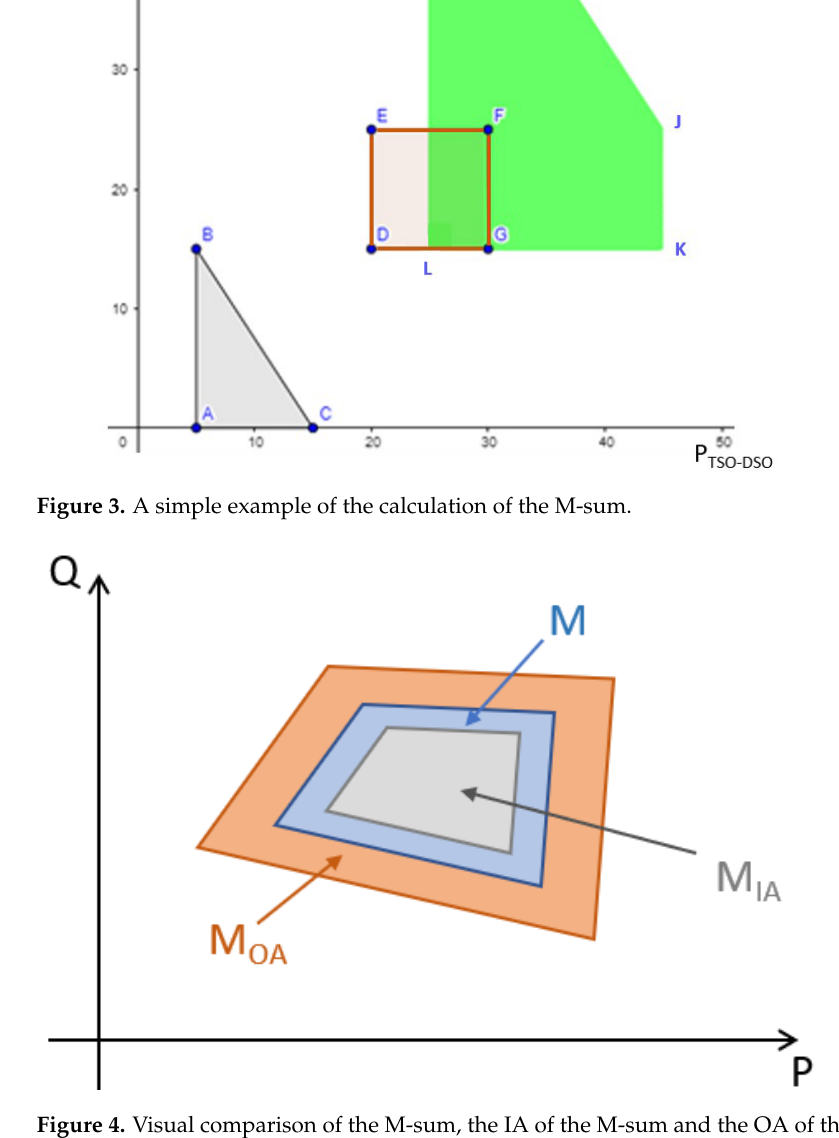
Figure 3. A simple example of the calculation of the M-sum.